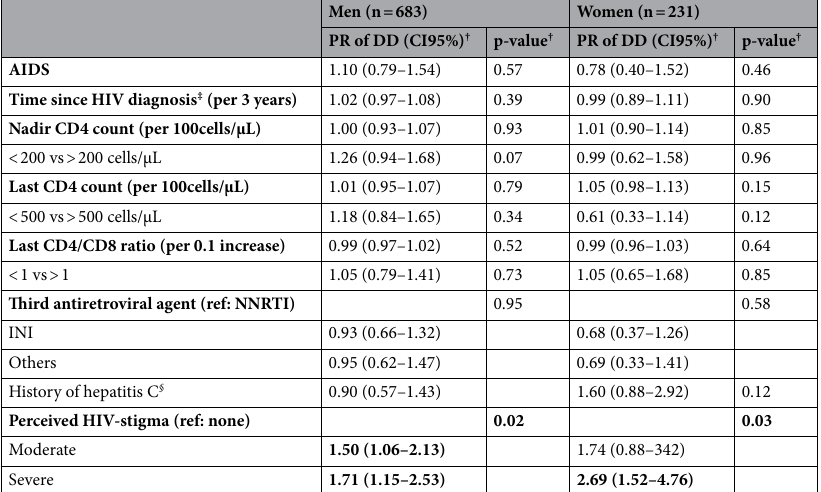
Table 2. Associations between HIV-specific factors and depressive disorders (DD) in multivariable analysis, after multiple imputation of missing data, in men and women (n = 914). DD depressive disorder, INI integrase inhibitors, MSM men who have sex with men, NNRTI non nucleosidic reverse transcriptase inhibitor, PR prevalence ratio (Poisson regression with robust variance). † All PR are adjusted for age, place of origin, highest level of education, net monthly household income, employment status, partnership status, family ties, social support, alcohol and cannabis use, age-associated comorbidities and pain status. In men, analyses were also adjusted for MSM status and recreational drug use. Bold results are statistically significant for p-value of likelihood ratio test < 0.05. ‡ Plus adjustment for AIDS. § Plus adjustement for HIV transmission via Intravenous drug